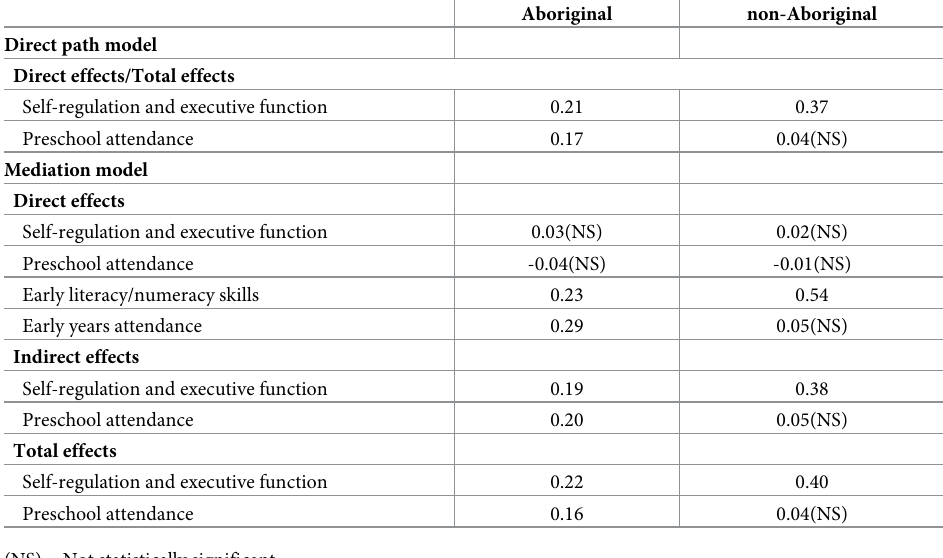
Table 2. Standardised direct and indirect effects (i.e. β ) of self-regulation/executive function and preschool atten- dance on Year 3 academic outcomes with early literacy/numeracy skills and early years attendance as mediators.